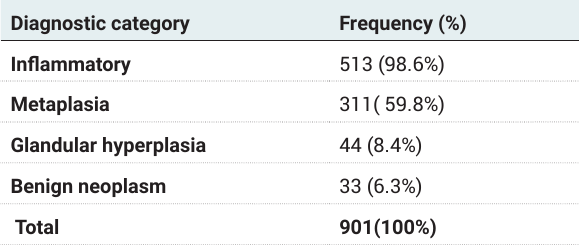
Table 2: Various diagnostic categories and its